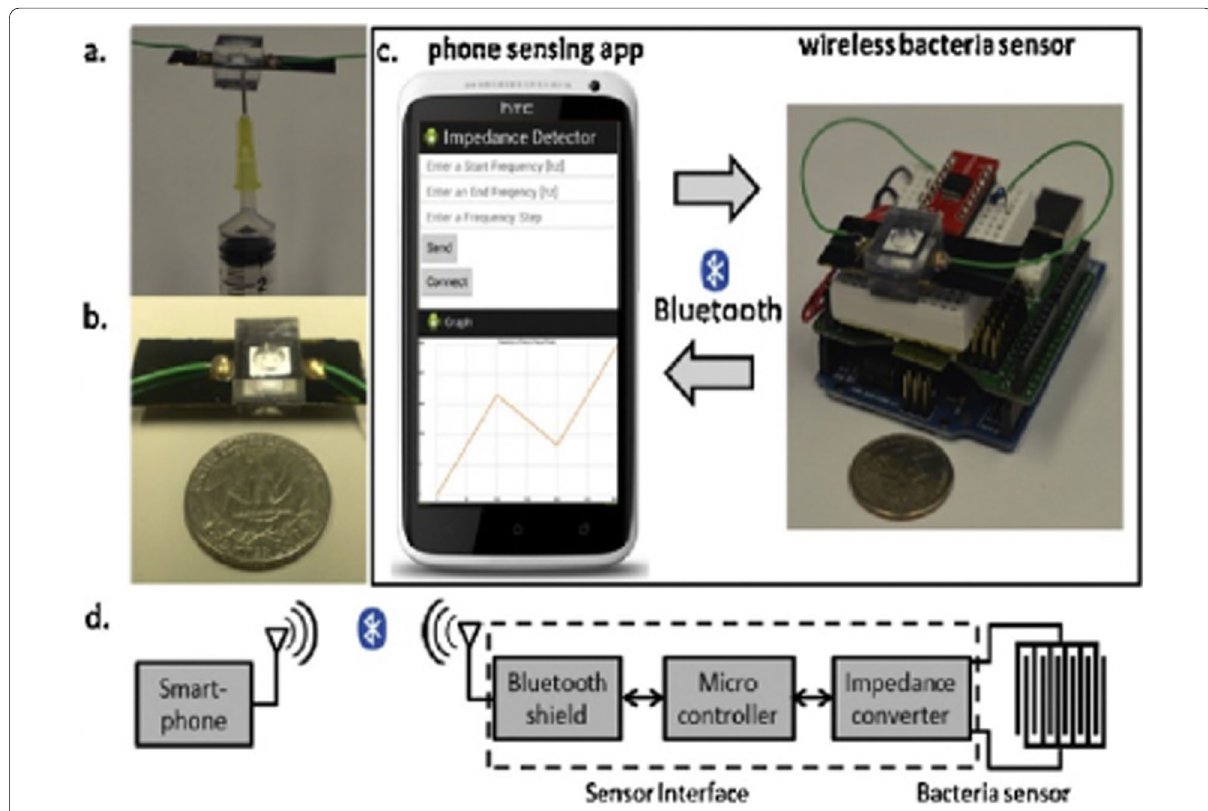
Fig. 5 Electrochemical detection of bacteria using of wireless cell phones (Jing Jiang